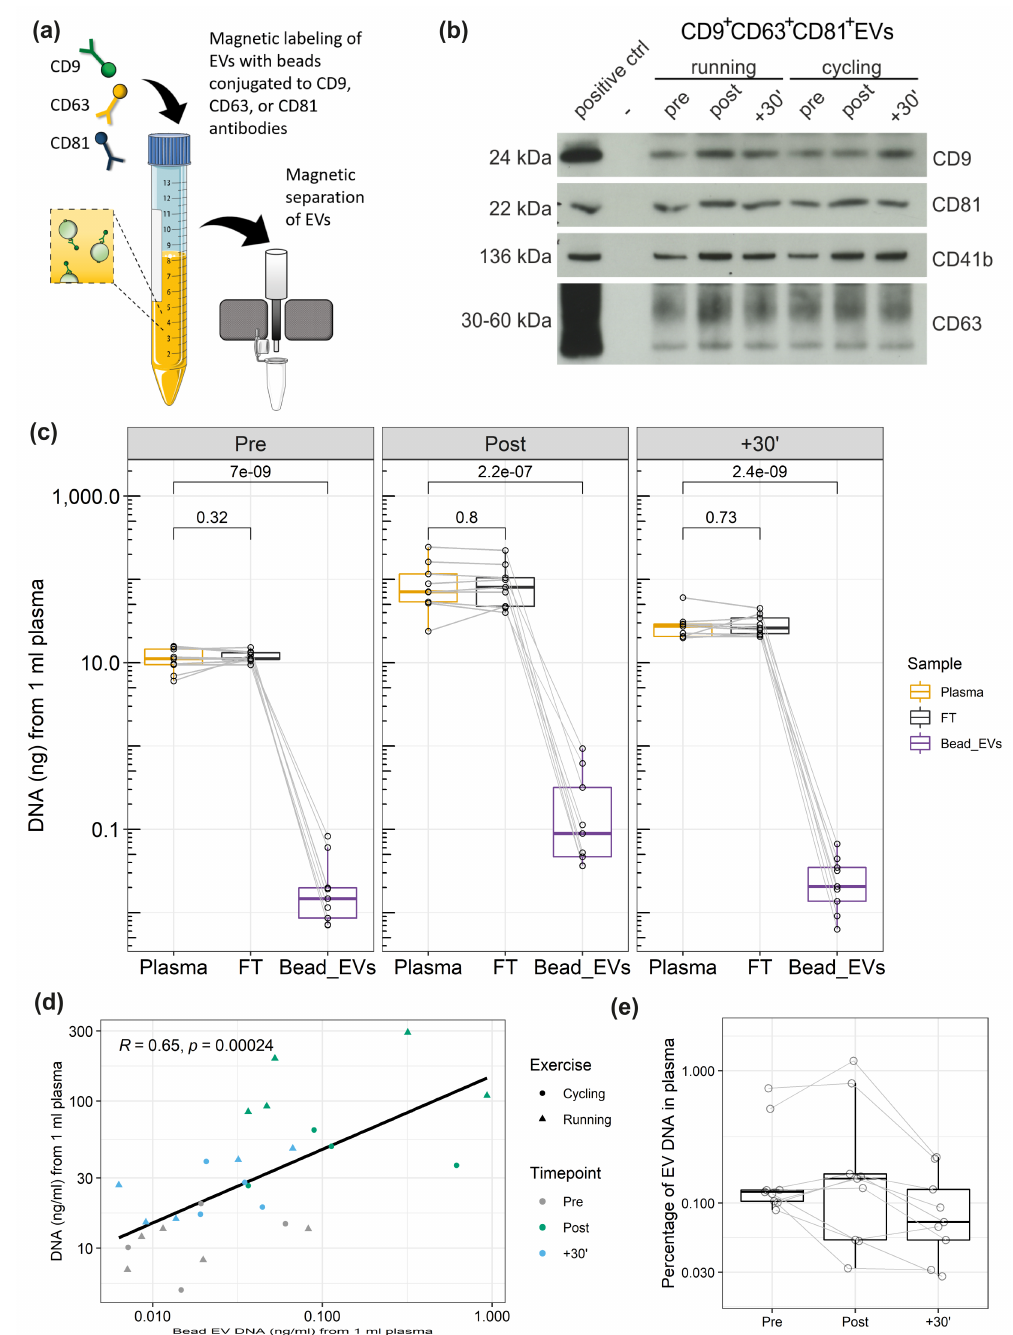
Figure 3. DNA associated to CD9 + /CD63 + /CD81 + EVs. ( a ) Illustration of extracellular vesicle (EV) immunobead isolation (anti-CD9/CD63/CD81). ( b ) Western blot detection of EV proteins CD9, CD81, CD63, as well as platelet specific marker CD41b. ( c ) Amount of DNA in plasma, flow through, and CD9 + /CD63 + /CD81 + EVs. The values represent the amount of DNA from 1 ml of plasma. ( d ) Correlation between DNA amount in plasma and DNA amount of CD9 + /CD63 + /CD81 + EVs. ( e ) Percentage of CD9 + /CD63 + /CD81 + EV DNA in relation to the total DNA amount in